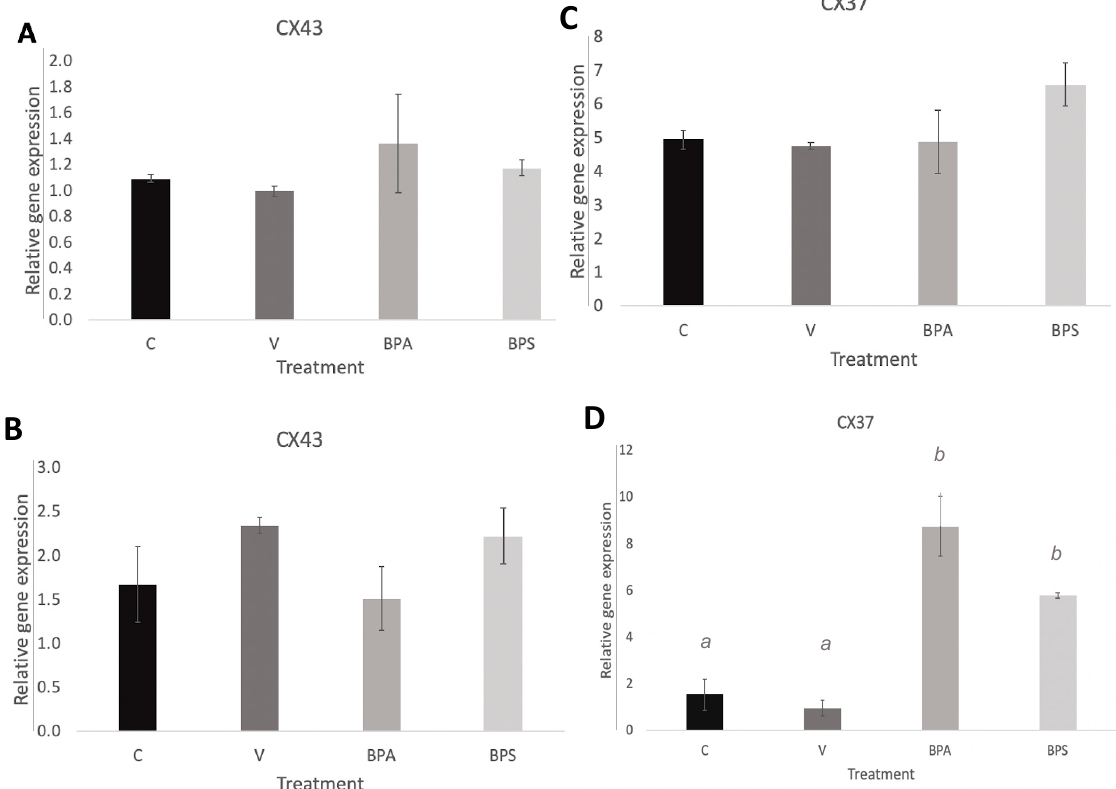
Figure 4. Connexin mRNA expression in bovine oocytes and cumulus cells. CX43 in oocytes ( A ) and in cumulus cells ( B ) as well as Cx37 in oocytes ( C ) and in cumulus cells ( D ) mRNA after 24 hours of maturation in S-IVM (C), S-IVM and 0.1% ethanol (V), S-IVM and 0.1% 0.05mg/mL (BPA), S-IVM 0.1% 0.05 mg/mL (BPS). Letters indicates statistical significance at p < 0.05, BPA ( p = 0.001) and BPS ( p = 0.017) and n = 3.